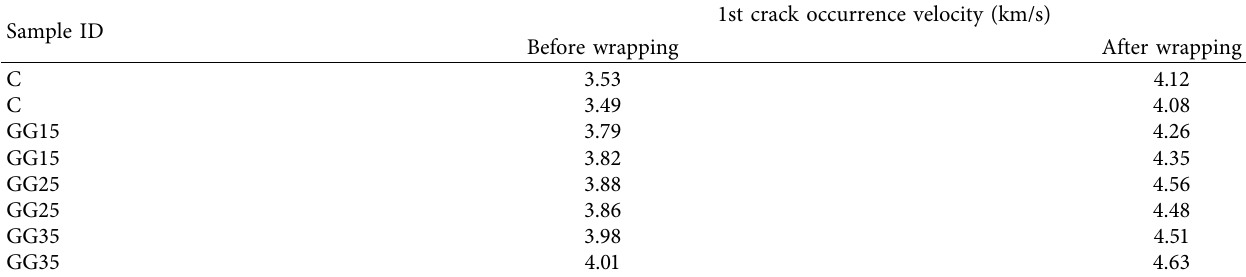
Table 2: Ultrasonic pulse velocity test